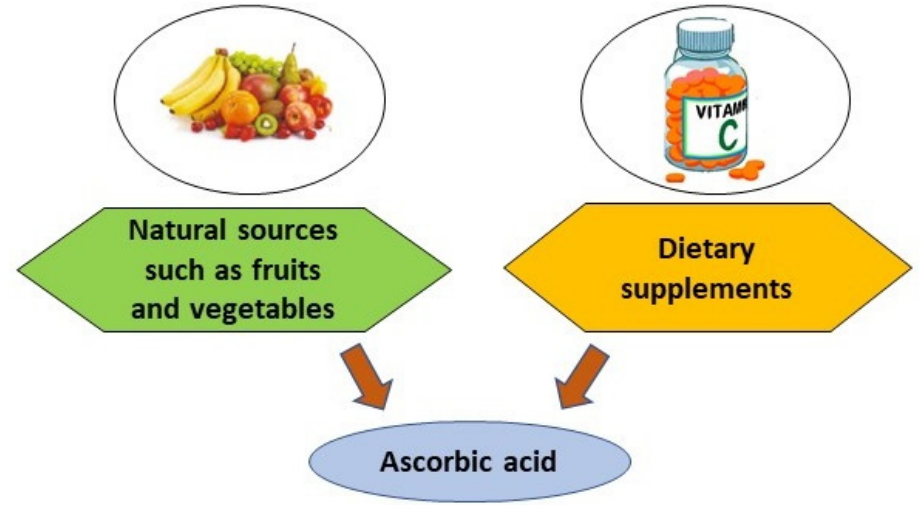
Figure 2. Sources of ascorbic acid.